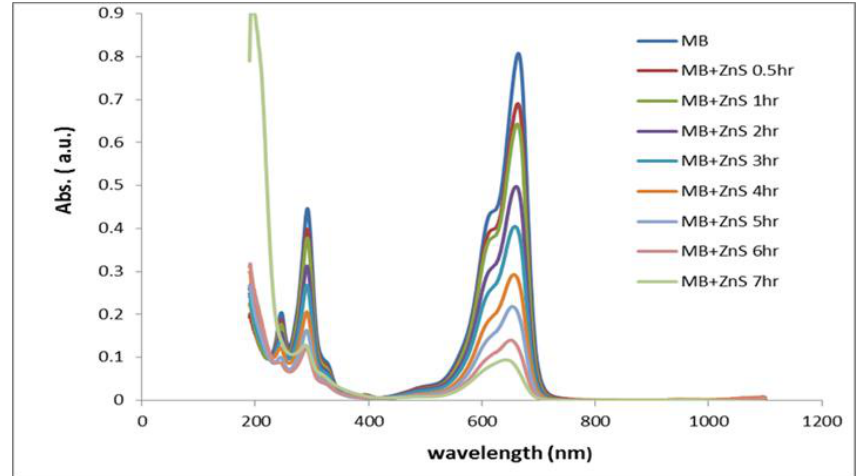
Fig. 4: Absorption spectra of ZnS in various time.